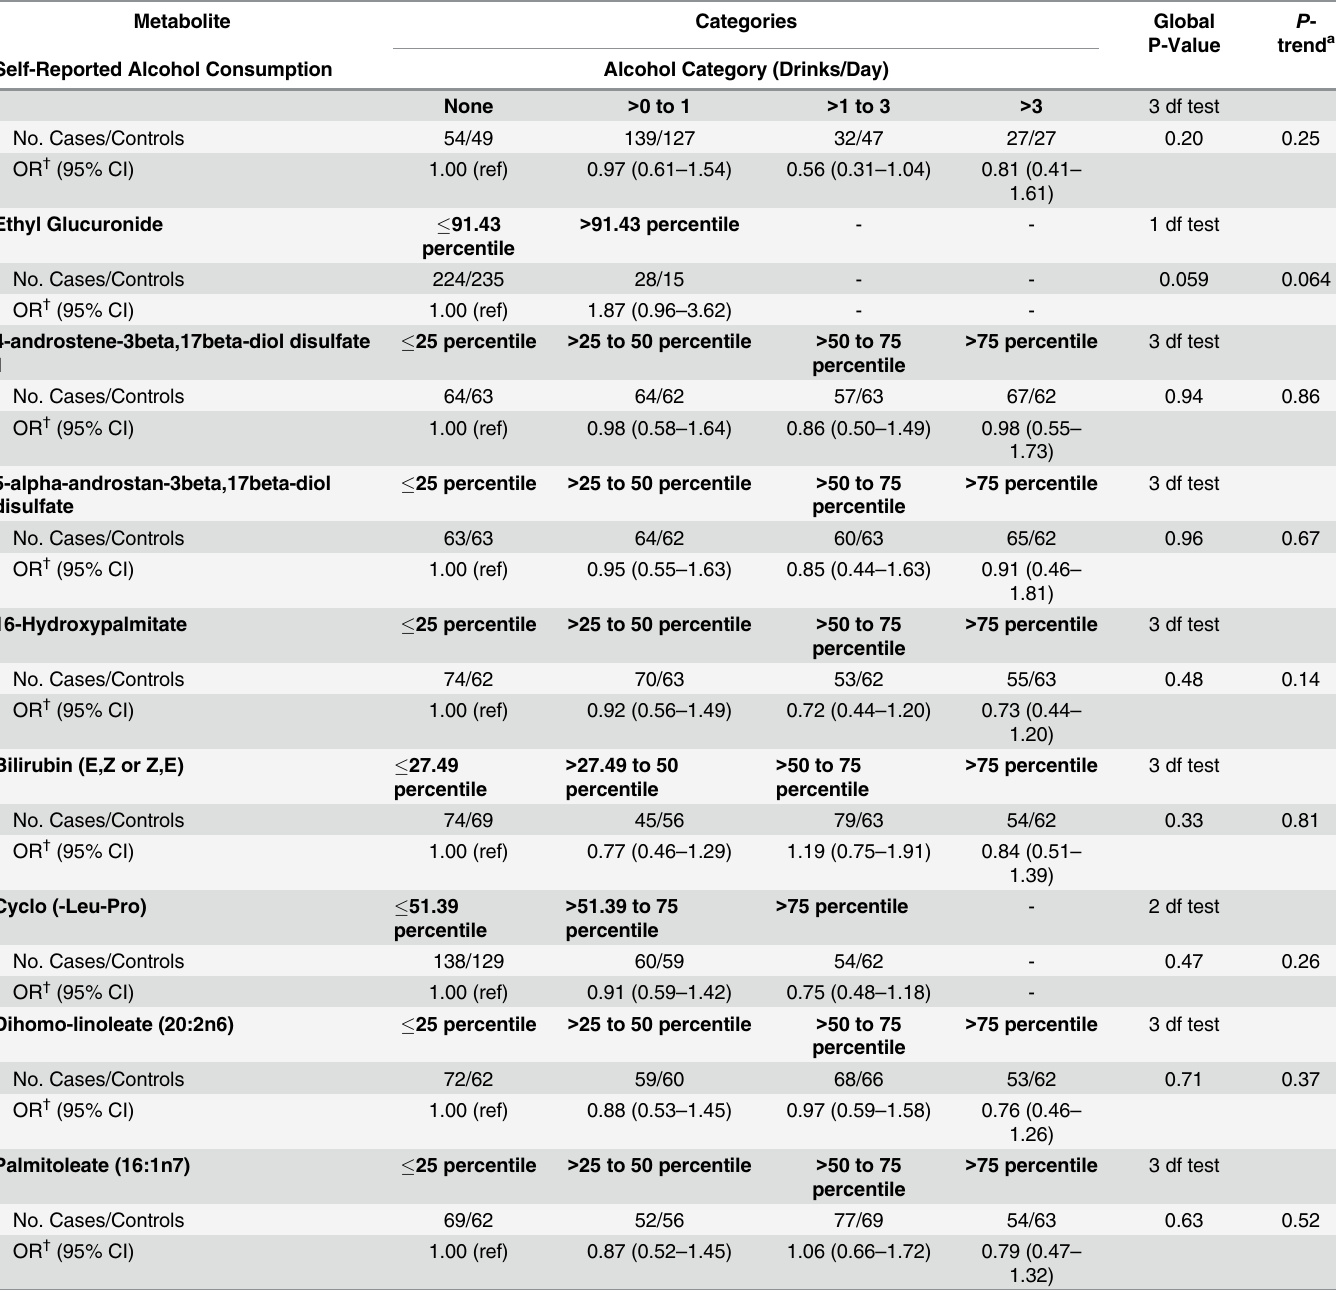
Table 3. Adjusted Odds Ratios and 95% Confidence Intervals for the Association Between Self-Reported Alcohol Consumption/Alcohol Consump- tion-Related Metabolites and Colorectal Cancer in 502 US Adults (PLCO).